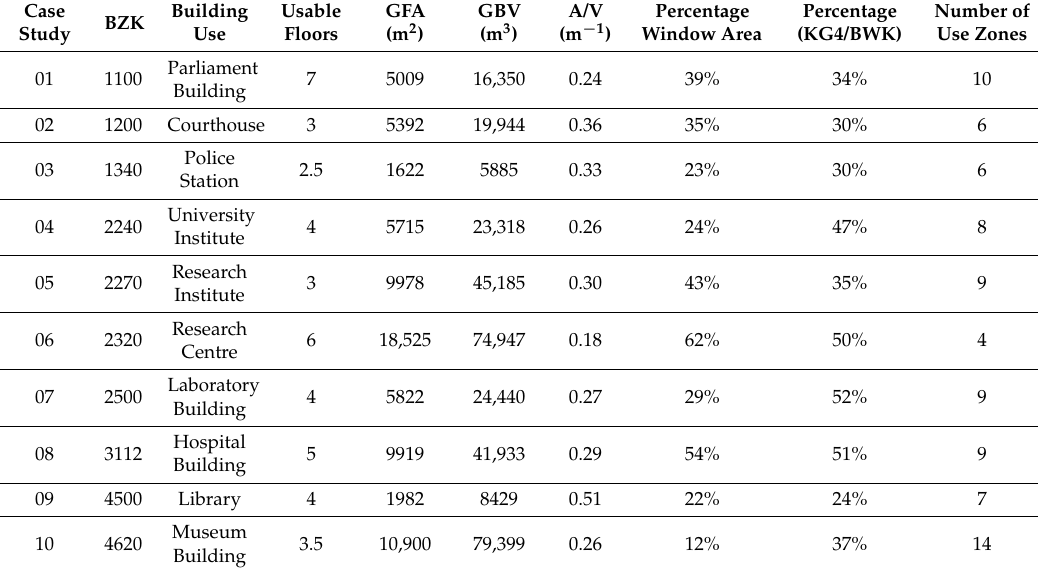
Table 1. Overview of the case studies with the categories code by Bauwerkzuordnungskatalog (BZK; this catalogue defines building uses using a four-digit code [11]), building use, number of usable floors (UF), gross floor area (GFA), gross building volume (GBV), the ratio of envelope area to volume (A/V), the percentage of window area to the envelope area, the percentage of the construction costs of technical installation to the overall construction costs (KG4/BWK), and the number of usage zones for energy performance calculations according to DIN V 18599-10